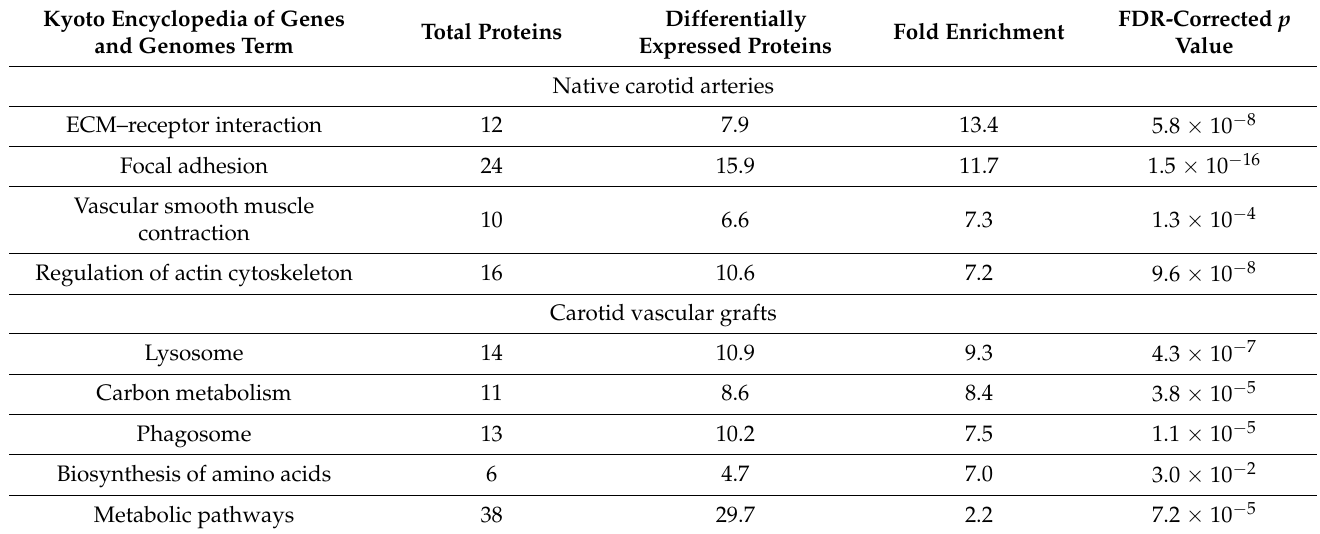
Table 8. Biological processes involving the proteins which are upregulated in either native carotid arteries or TEVGs (annotated according to the Kyoto Encyclopedia of Genes and Genomes